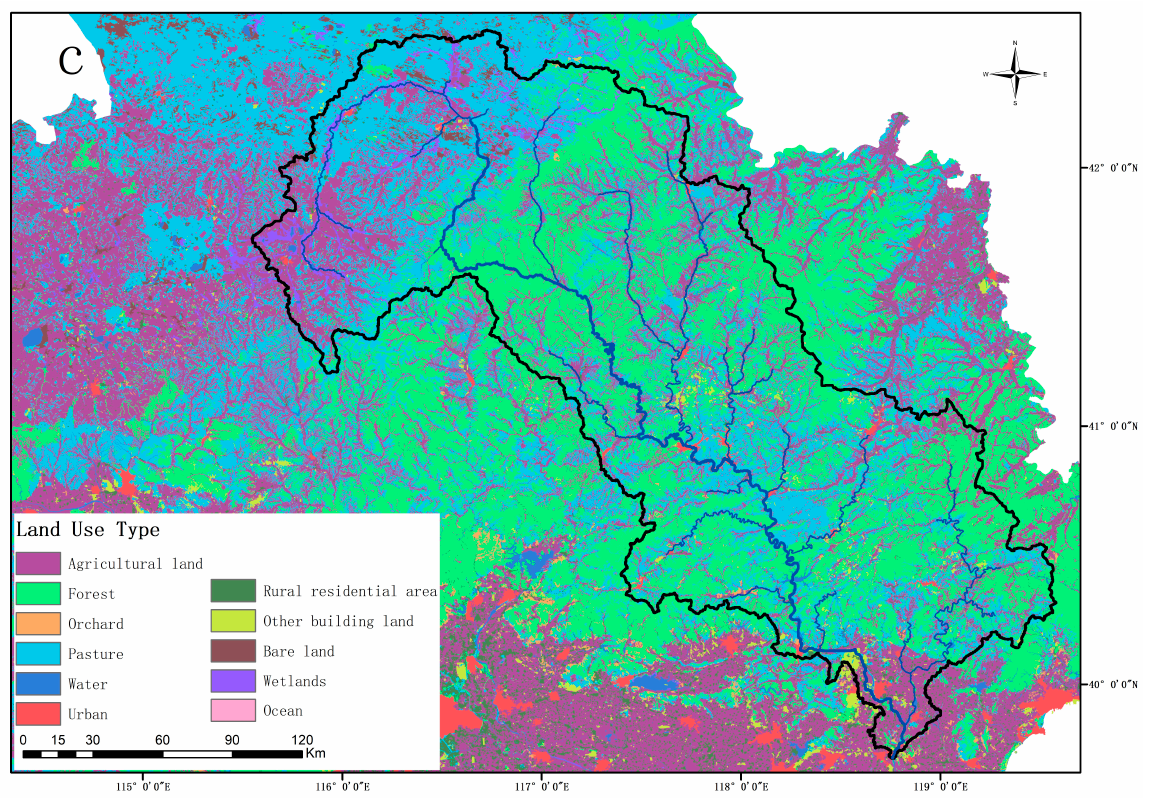
Figure 1. Study area. ( a ) Location of Luanhe and Haihe basins in China; ( b ) topography, river streams, and hydrological stations in the study basin; the mainstream of Luanhe is divided into 22 calculation units from upstream to downstream, the classification number in Figure ( b ) was the sequence number of calculation unit ID, and WECs were estimated based on each unit separately (these calculation units were labeled as Reach 1–Reach 22 in the following context); ( c ) land-use types in 2015 from China resource and environmental data platform.